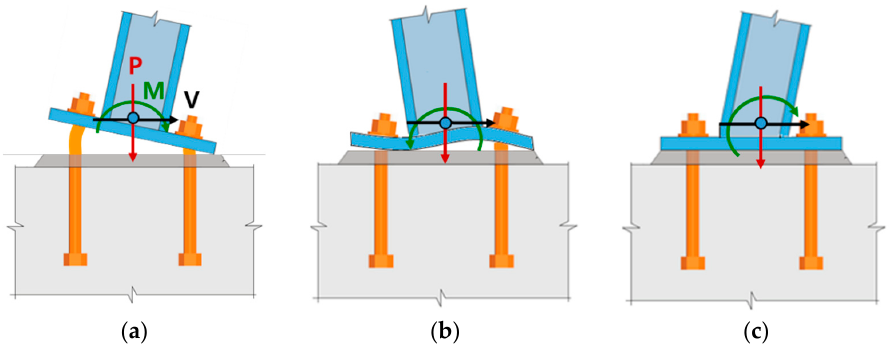
Figure 6. Sources of ductility in the anchor zone. ( a ) Anchor yield. ( b ) Anchor support yield. ( c ) Structure/equipment yield.